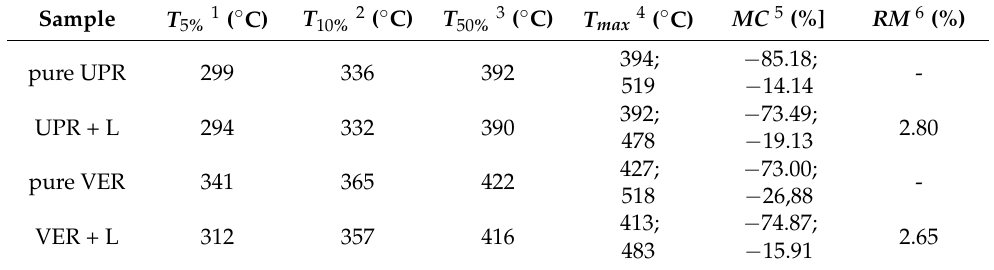
Table 2. Thermogravimetric analysis data for the UPR and VER composites with kraft lignin.